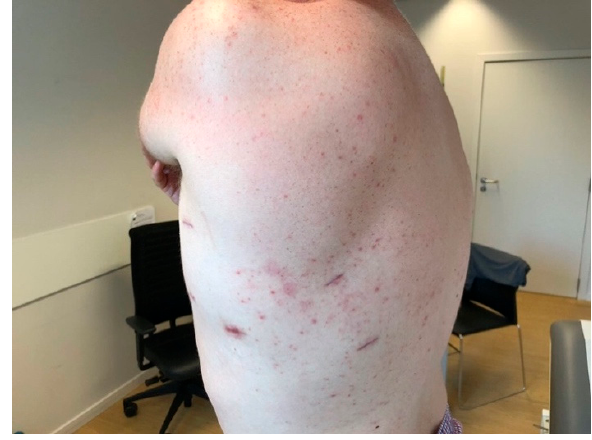
Figure 7. Posterior trocar access scars.